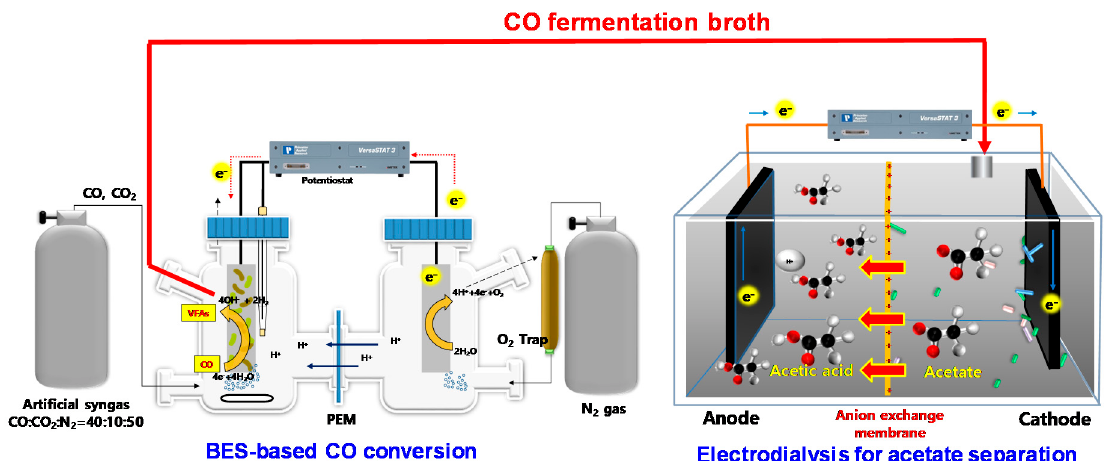
Figure 1. Separation and concentration of acetate from CO fermentation broth by electrodialysis cell. BES: Bioelectrochemical system.